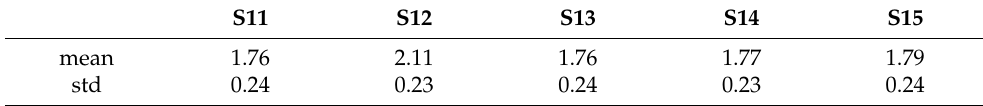
Table 4. Comparison of estimation accuracy in the five examined scenarios in Section